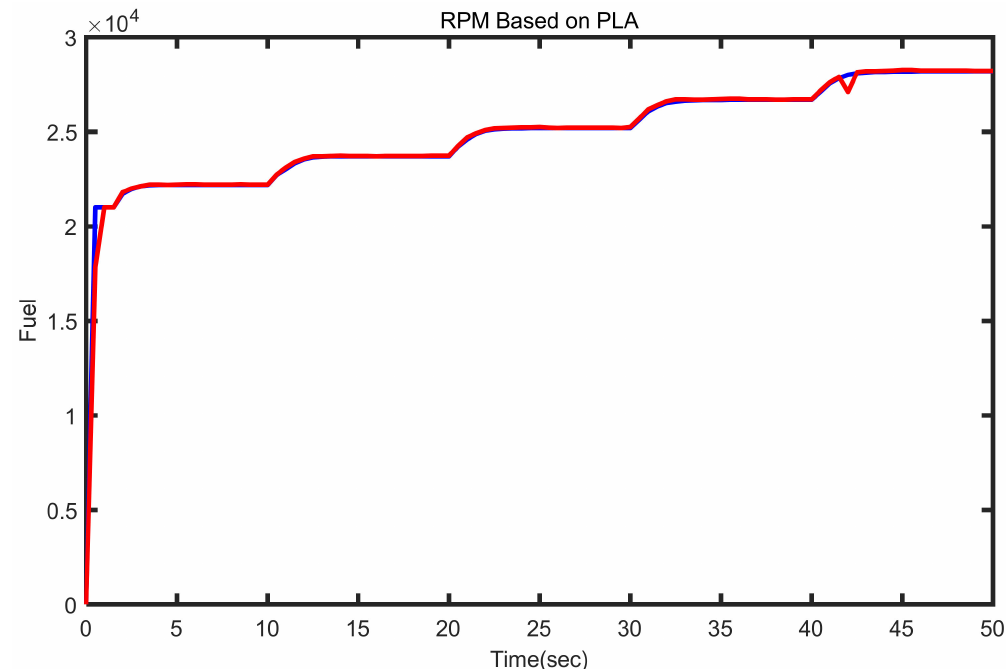
Figure 18. MIL and HIL RPM signal comparison for MMFC.